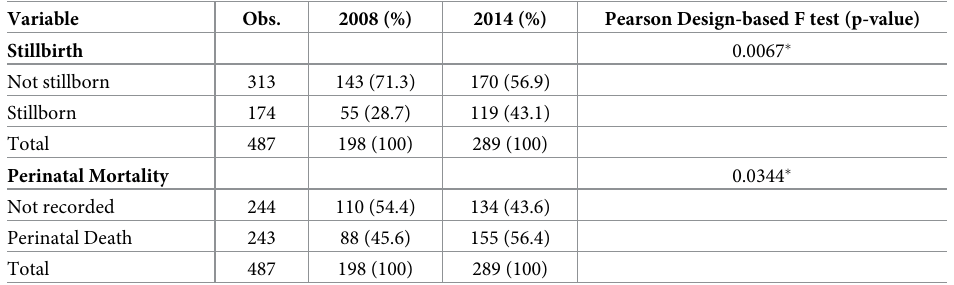
Table 5. The proportion of stillbirths and perinatal mortality in 2008 and